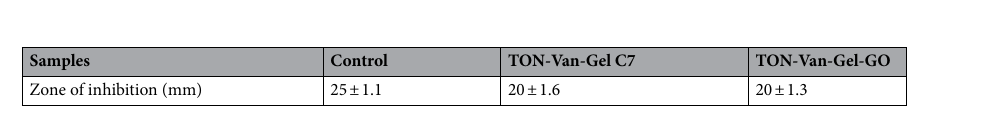
Figure 10. Disc diffusion assay to evaluate the antibacterial property of (a) TON-Van-Gel C7, and (b) TON- Van-Gel-GO.